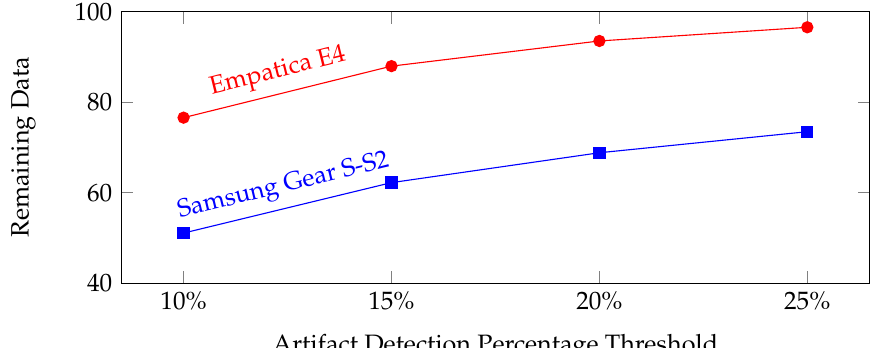
Figure 9. Percentage of the remaining data (for both device types) after the artifacts are removed versus different percentage thresholds of artifact detection